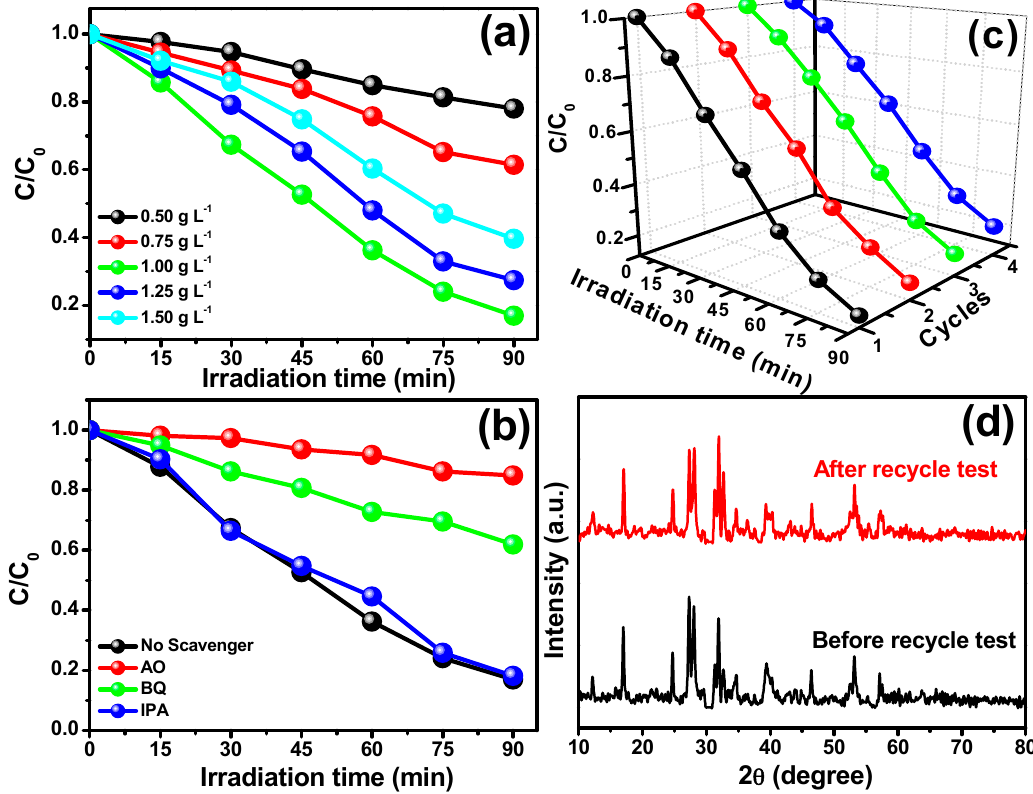
Figure 9. ( a ) Effect of catalyst dosage from 0.50 g L − 1 –1.50 g L − 1 , ( b ) effect of scavengers on the degradation of RhB, ( c ) the recycling runs for the degradation of RhB using the optimized FeAVO-3 nanocomposite in visible-light irradiation and ( d ) XRD patterns of the optimized FeAVO-3 nanocomposite before and after recycling test.